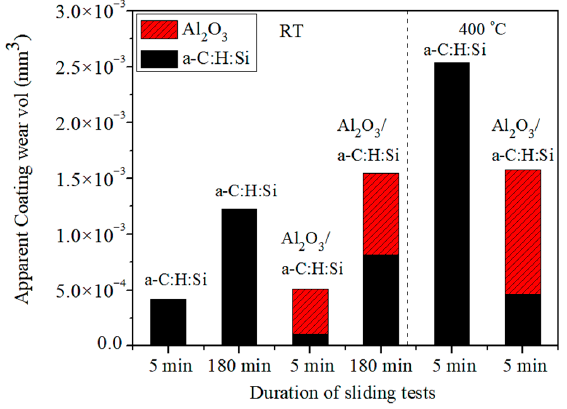
Figure 6. Apparent wear volumes measured on the a-C:H:Si and Al 2 O 3 /a-C:H:Si coatings.